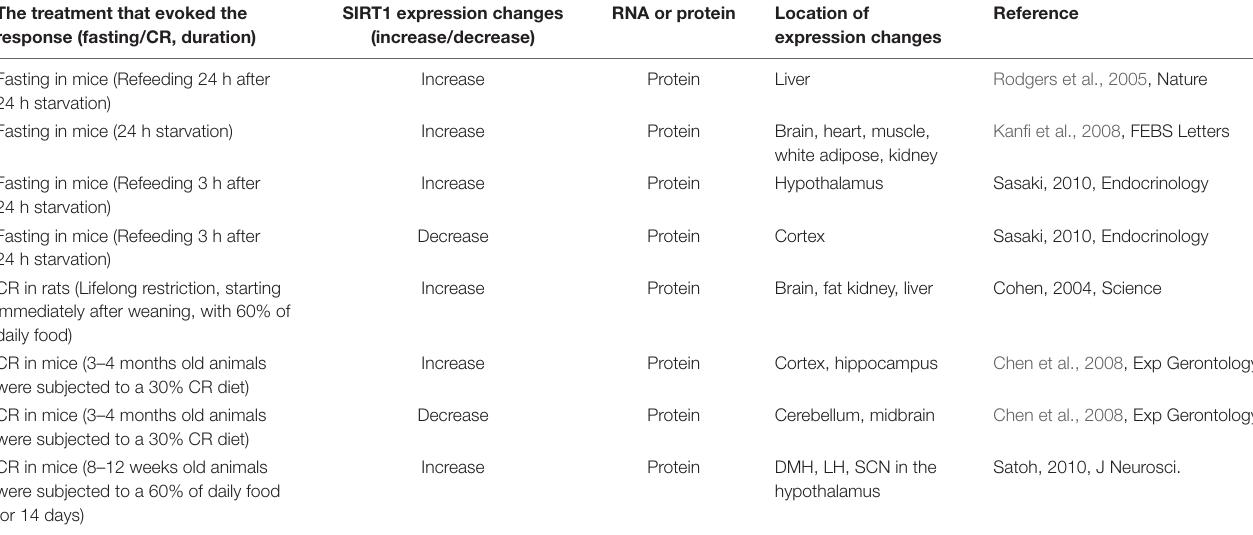
TABLE 1 | The expression changes of SIRT1 in the hypothalamus. The treatment that evoked the response (fasting/CR,